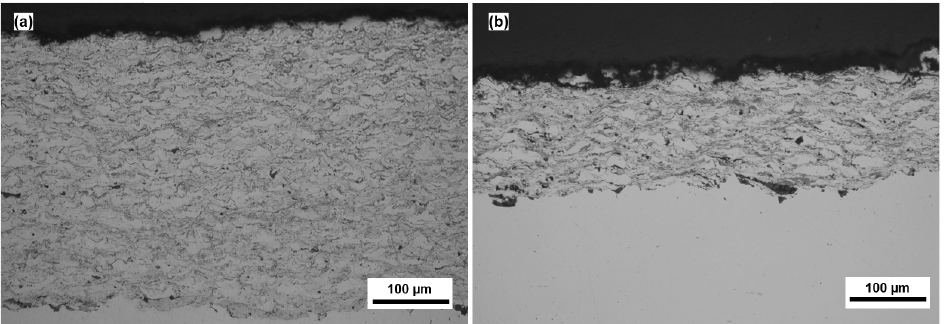
Figure 1. Micrographs of ( a ) SiC particles, ( b ) NiCrAlY powder, and ( c ) Cr 3 C 2 -25NiCr powder.